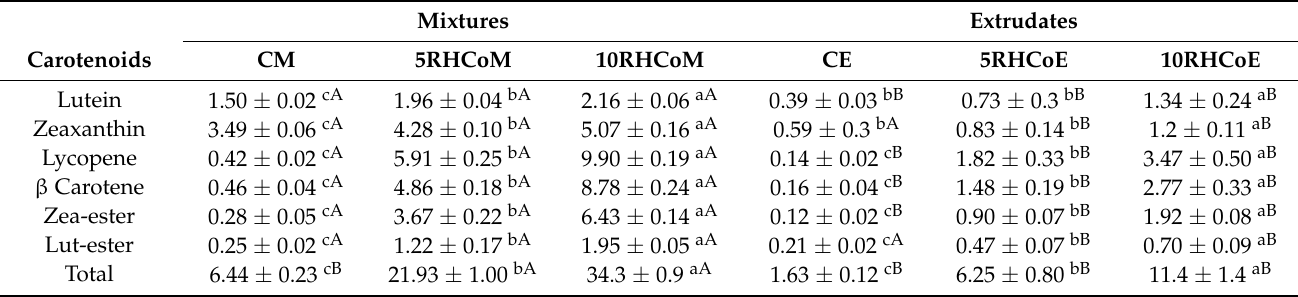
Table 8. Carotenoids content ( µ g/g dry weight ) of corn mixtures and extrudates. Mean values ± standard